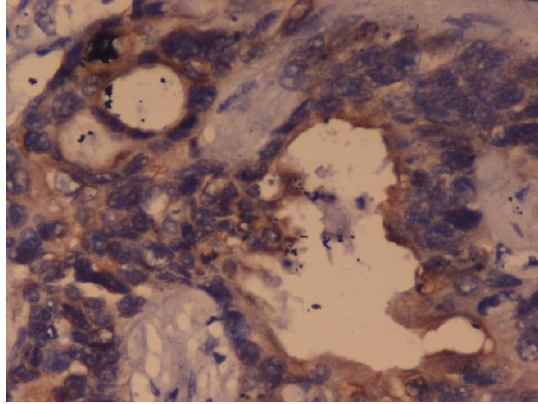
Figure 4. MTSCC: Immunohistochemistry showing diffuse positivity for cytokeratin in the tumour cells. IHC cytokeratin,